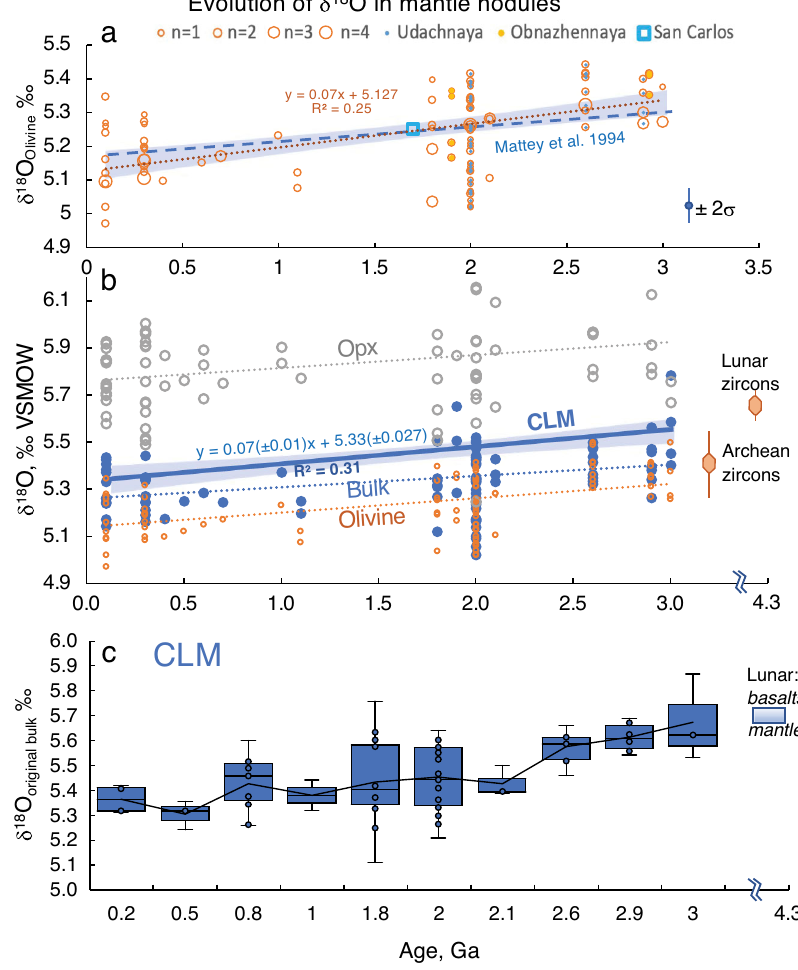
Fig. 1 Evolution of oxygen isotopes in lithospheric continental mantle (CLM). Temporal trends of δ 18 O olivine ( a , b ), orthopyroxene and bulk ( b ), and CLM corrected for melt depletion ( b , c ) in studied mantle nodules. Bulk is computed based on modal mineral abundances and δ 18 O values of olivine and orthopyroxene (T Supplementary Table 1). Zircon from the Archean Kaapvaal cratonic mantle is from ref. 50 , and zircon and basalts from the moon are from refs. 12,51 , lunar mantle estimate is based on zircon, olivine, and basalts (see the text). Notice decreasing trends (95% conf. interval error envelope in line fi t) and inbox diagrams.